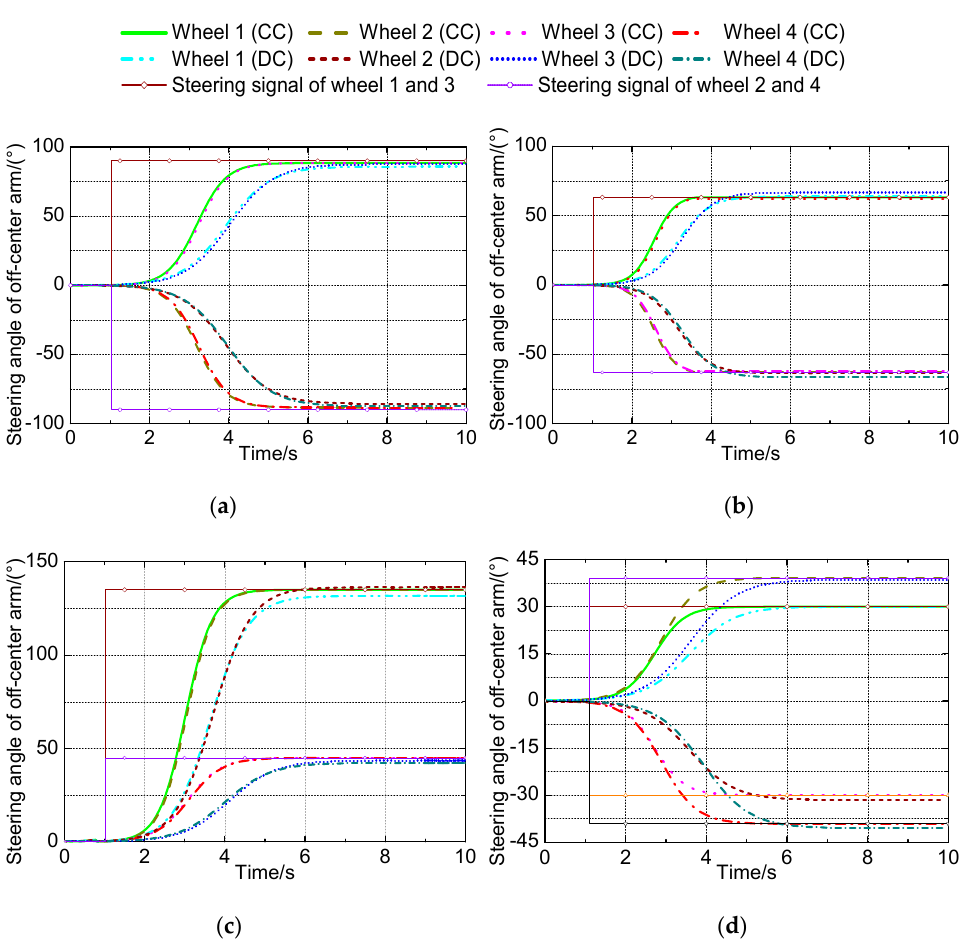
Figure 9. Steering angle curves of four off-center arms during motion mode switching: ( a ) cross motion; ( b ) in-place rotation; ( c ) diagonal motion; ( d ) steering motion.